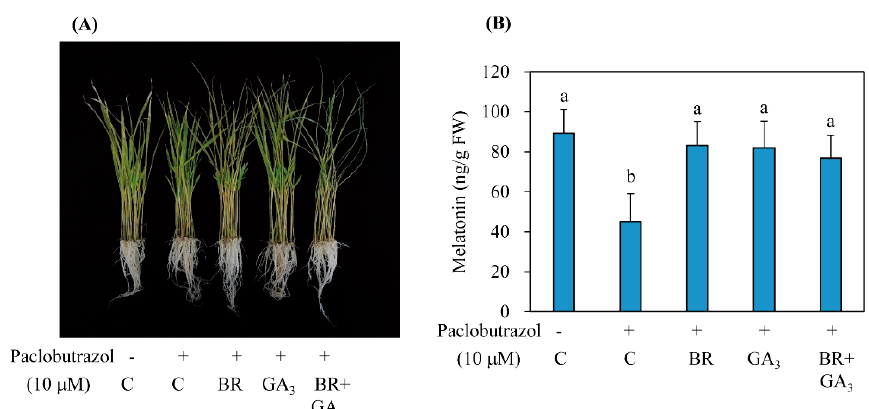
Figure 7. Restoration of melatonin synthesis by BR treatment under conditions of inhibition of GA